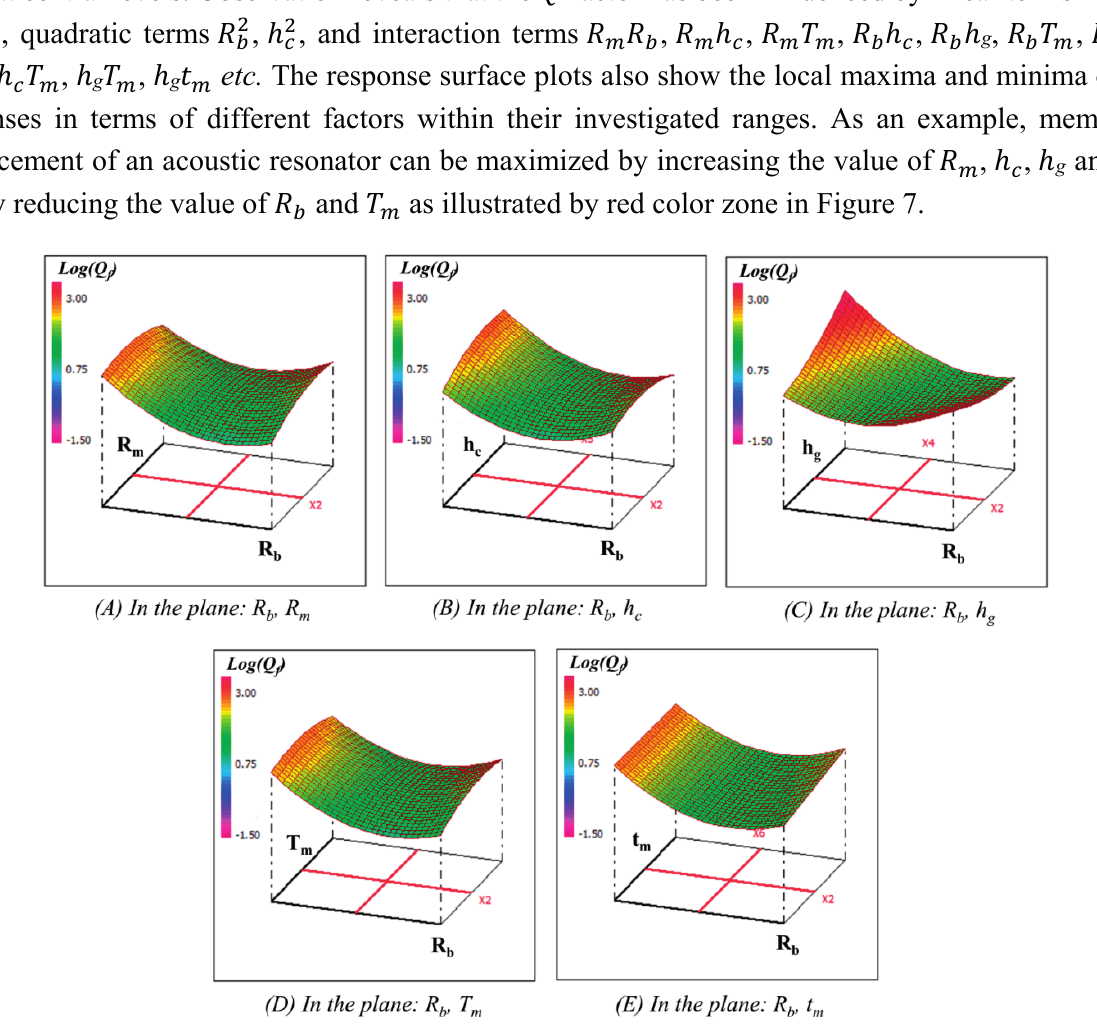
Figure 8. Response surface plots of logarithm of quality factor (Log(Q f )) in different planes with respect to other factors kept constant at the central